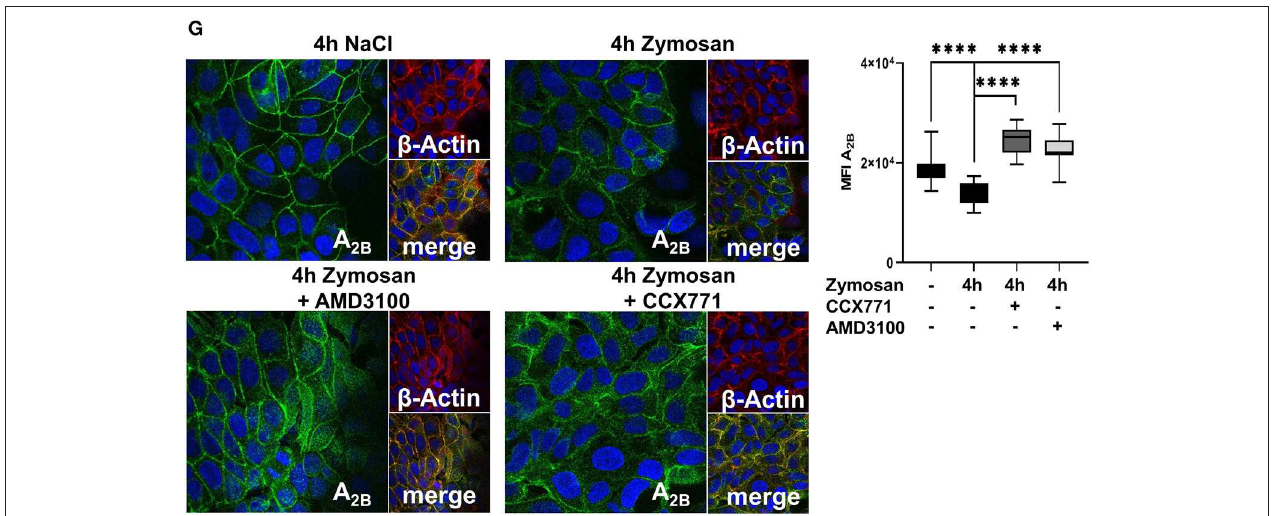
FIGURE 8 | Effects of the adenosine receptor A 2B blockade on permeability and cytokine release in vitro . (A) Expression of occludin (OCLDN; green) and (B) tight junction protein 1 (TJP1; green) in human epithelial cells ( β -Actin; red) 4h after NaCl or zymosan with or without AMD3100 or CCX771 (63x original magnification). Images are representatives of n = 3 experiments. (C) Fluorescence intensity of occludin and TJP1 was measured at indicated conditions by using ImageJ ( n = 8–12). (D) TJP1 expression and the effects of CXCR4 and CXCR7 inhibition after adenosine receptor A 2B knock down was evaluated ( n = 8–10). (E) The inflammation-related release of human IL6 and IL8 from epithelial cells and (F) the effects of A 2B -siRNA were determined in cell supernatants at indicated conditions ( n = 8–12). (G) Protein levels of A 2B (green) in human H441 cells ( β -Actin; red) at indicated conditions (63x original magnification). Image are representatives of n = 3 experiments. Fluorescence intensity was measured by ImageJ ( n = 8–12). For statistical analysis, one-way ANOVA was used with Bonferroni post-hoc test. Data are presented as box and whisker graph with error bars indicating the range from minimum to maximum value; * p < 0.05; ** p < 0.01; *** p < 0.001; **** p <